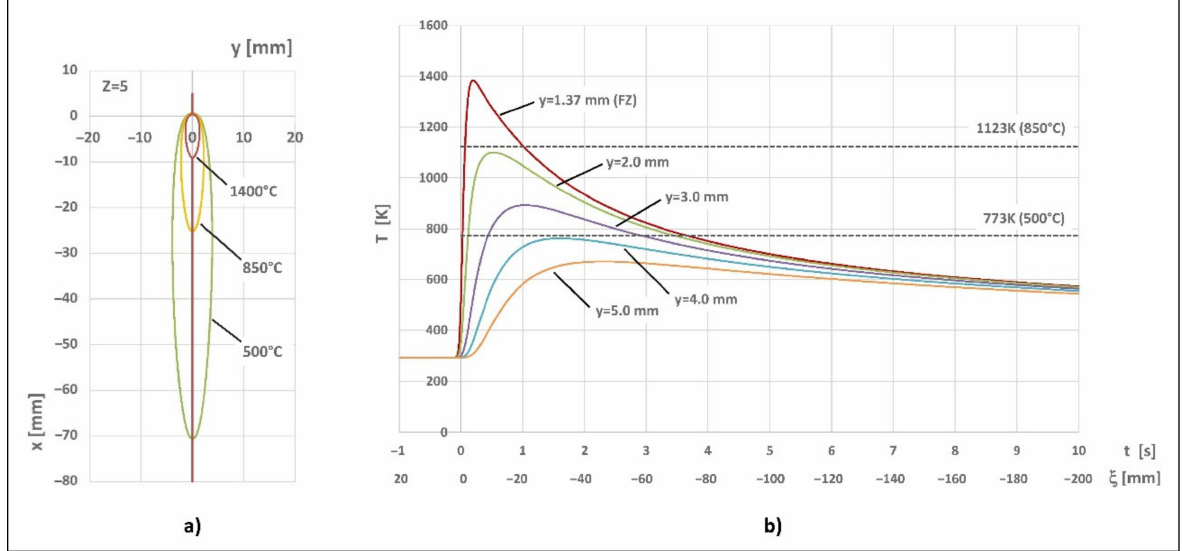
Figure 4. Results of the simulation: ( a ) isotherms in the plane xy (z = 5 mm); ( b ) temperature–time curves for fixed points on the plane xy, at z = 5 mm, parameterized at different values of the y coordinate (distance of the point from the welding plane).